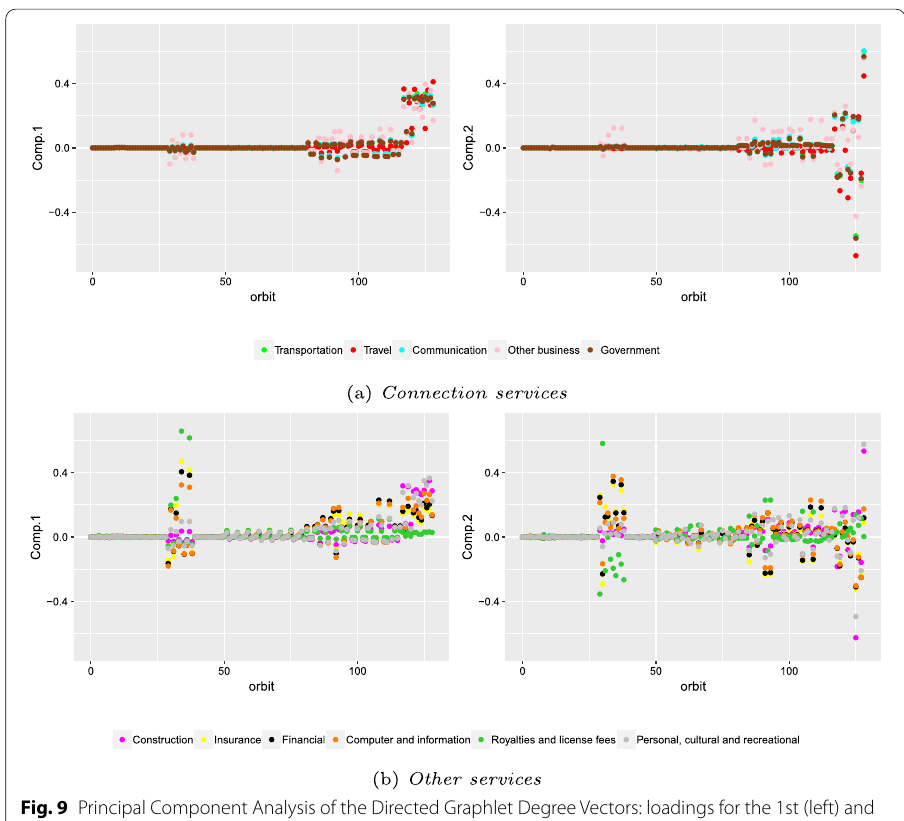
Fig. 9 Principal Component Analysis of the Directed Graphlet Degree Vectors: loadings for the 1st (left) and 2nd (right) principal components, for the group of Connection services (above) and Other services (below)